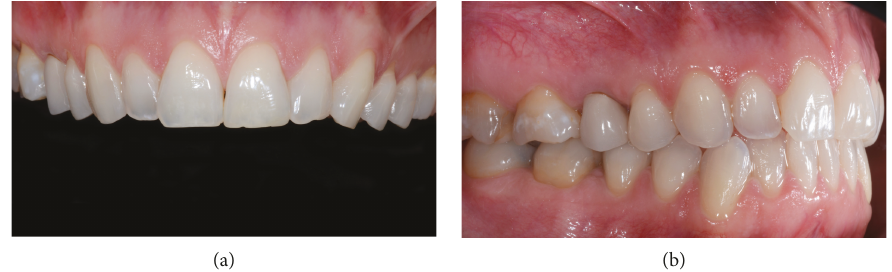
Figure 5: Frontal (a) and lateral (b) views 7 years after crown delivery: an overall dental deterioration is visible associated with soft tissue modi fi cations.